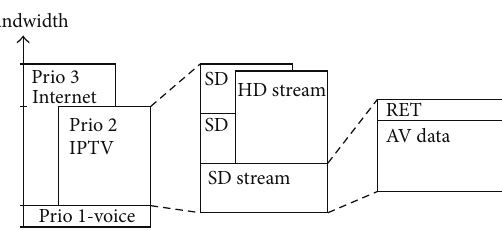
Figure 1: Bandwidth allocation in the access network.